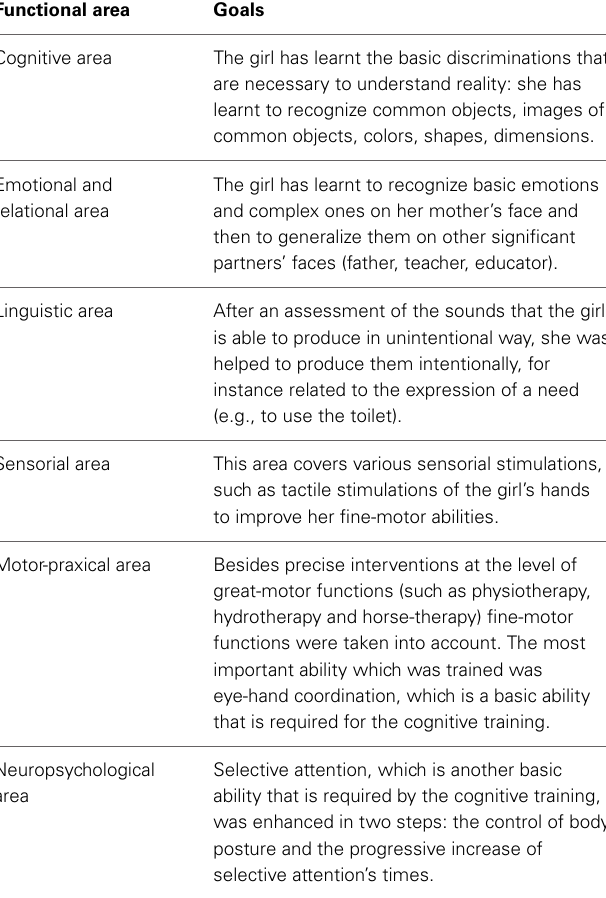
Table 1 | Basic principles of the intervention of modificability and mediated learning.